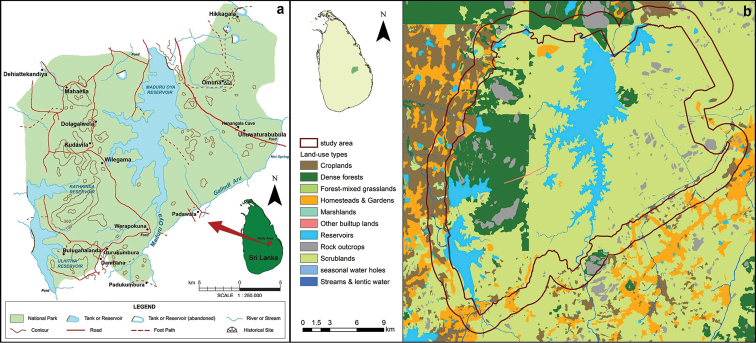
a the local topography, road network, local towns and hydrology and b land–used types (the 2km-wide study area is delineated by solid lines) in and around Maduru-Oya National Park.